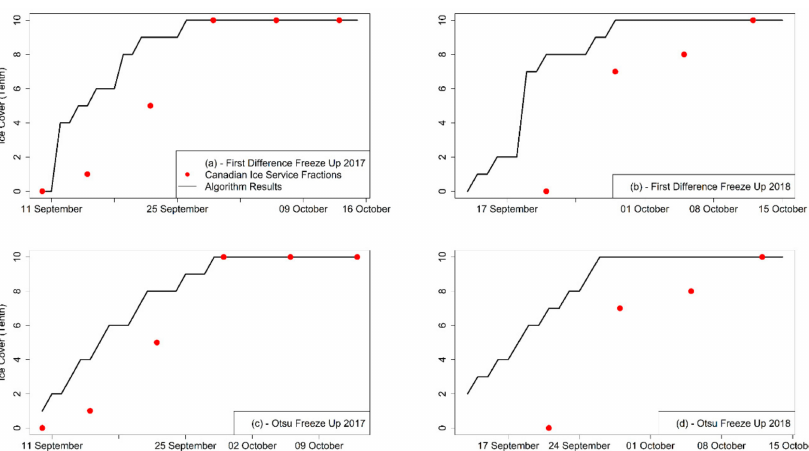
Figure 18. Comparison of ice cover fractions from the Canadian Ice Service (CIS) to those estimated from the first di ff erence and Otsu methods during the freeze-up period. ( a , b ) show the lake ice cover fraction estimated by the first di ff erence method compared to the CIS estimates. ( c , d ) show the lake ice cover fraction estimated by the Otsu method compared to the CIS